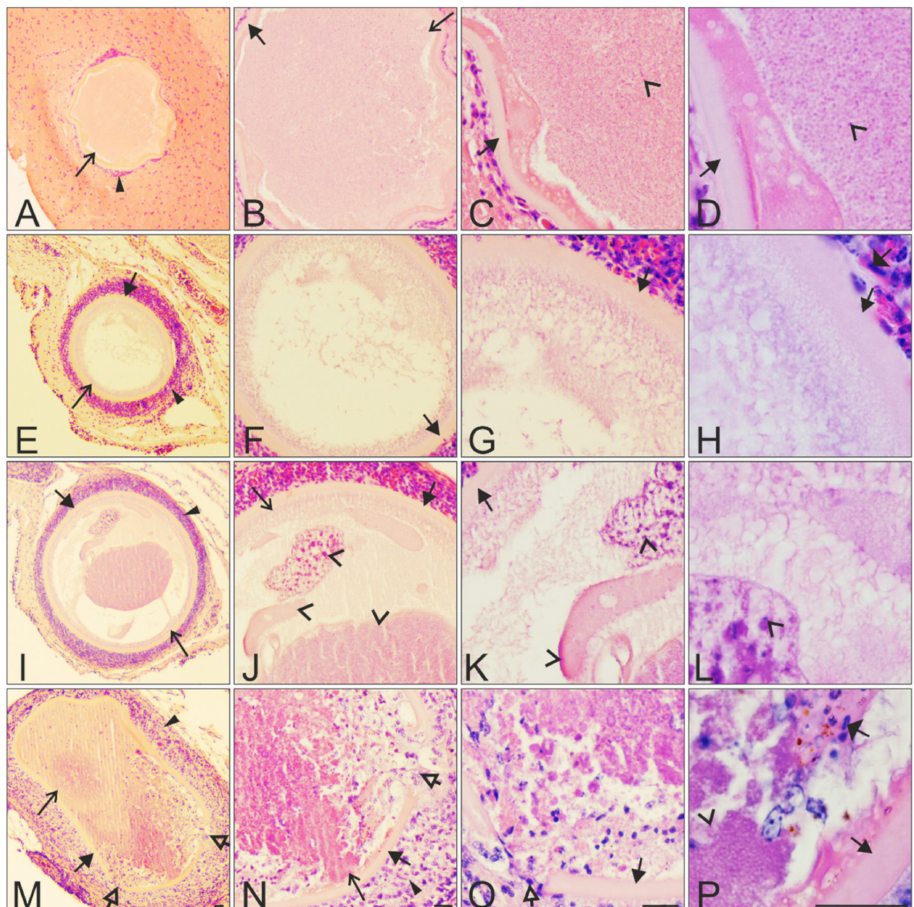
Figure 3. Megalomeronts of Haemoproteus pastoris (lineage hLAMPUR01) in the cerebellum of the brain ( A – D ) and esophagus ( E – P ) of naturally infected Common starlings Sturnus vulgaris . Note the prominent capsular-like wall covering each megalomeront ( B – P ). The megalomeront in the brain was mature and overfilled with completely developed merozoites ( C , D ). Images E – L show two different histological sections of the same megalomeront, which was cut at different depths; as this megalomeront likely was a roundish body in 3D, the parasite in image I was bigger than in image E due to the location of the former section being closer to the center of the parasite. Note that developing cytomeres were present in section I (located closer to the center of the parasite) but not in section E (located closer to the periphery of the parasite), indicating uneven cytomere location during their development within the same megalomeront. It is possible that nuclear division started first at the center of the roundish megalomeronts (section I), and while the parasite grew, megalomeront division continued until the merozoites reached the extremities of the megalomeronts (section E). Images M–P show a mature ruptured megalomeront containing mature merozoites and infiltration of blood cells inside the megalomeront. Each megalomeront was shown at four different magnifications: A , E , I , M × 100; B , F , J , N × 200; C , G , K , O × 400, and D , H , L , P × 1000. Simple arrows ( )— megalomeronts. Filled-black triangle arrows ( )—capsular-like wall. Contoured-black triangle arrows ( )—rupture of the capsular-like wall. Flat triangle arrows ( )—red blood cells inside or outside the megalomeront. Triangle arrowheads ( )—deformed adjacent tissue cells suppressed by the megalomeront. Simple arrowheads ( )—merozoites. All scale bars = 20 µ